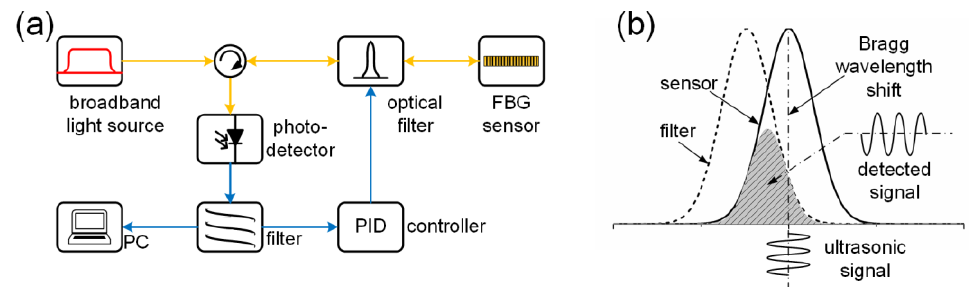
Figure 4. The FBG demodulation systems using a broadband light source. ( a ) The schematic diagram of the system setup; ( b ) the detection principle.